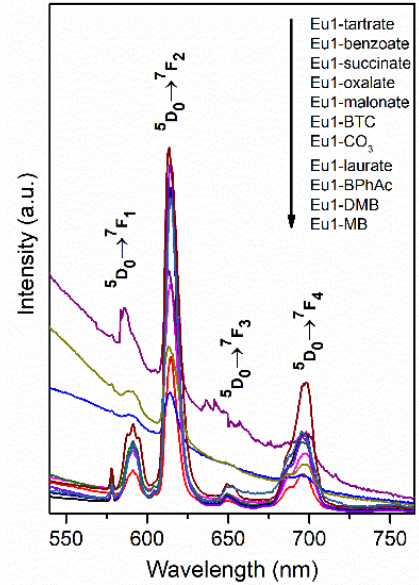
Figure 8. Emission spectra of Mg 3 /Al 0.99 Eu 0.01 and LDHs intercalated with tartrate, benzoate, succinate, oxalate, malonate, 1,3,5-benzentricarboxylate, laurate, 4-biphenylacetonate, 4- dimethylaminobenzoate and 4-methylbenzoate. (Ex = 394 nm).